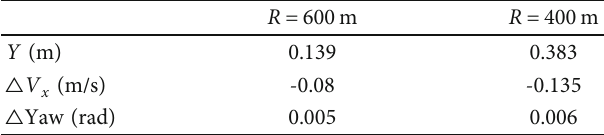
Table 2: Tracking state error at the end of T = 8